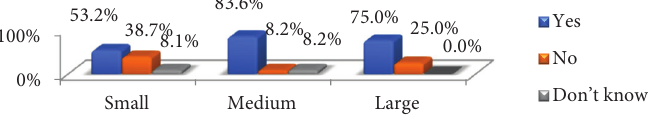
Figure 2. Use of financial controlling in the enterprises